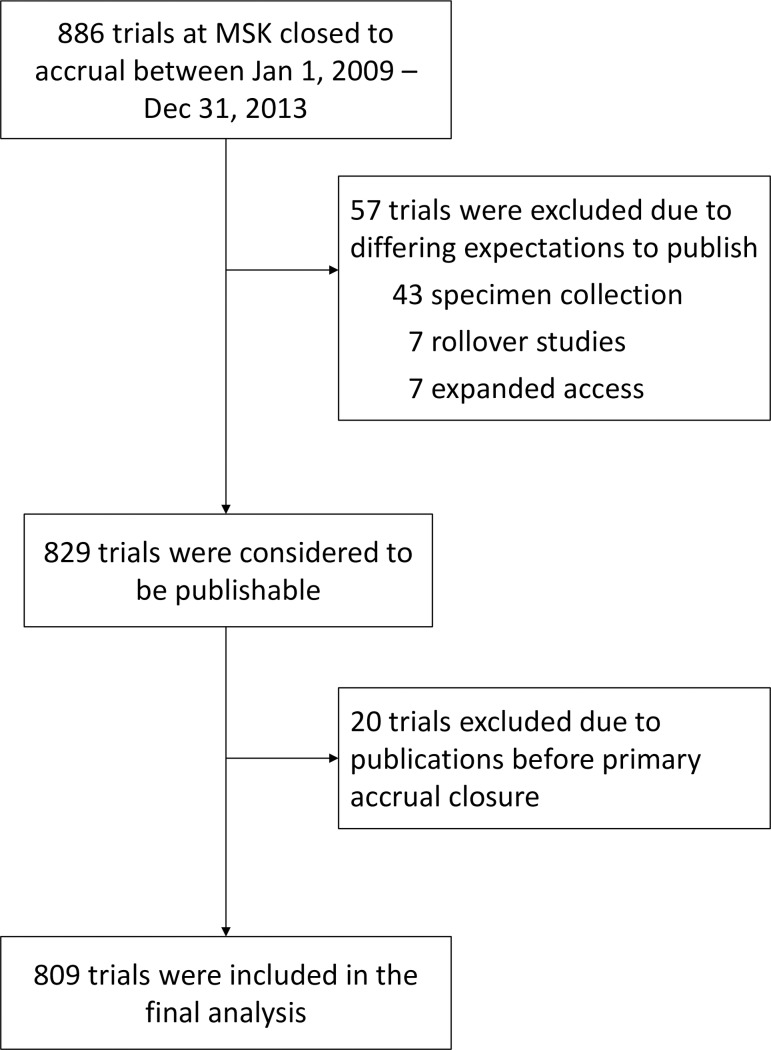
Consort diagram.